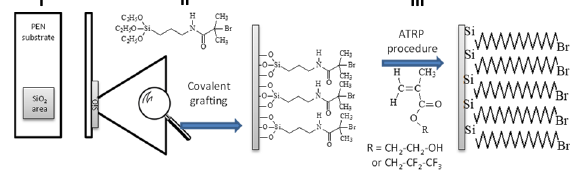
Fig. 2: General scheme summarizing the stepwise strategy used for surface modification of PEN substrate by (i) inkjet printing of silica pattern (0.5 * 0.5 mm 2 ), (ii) grafting the silane functionalised with the ATRP initiator and (iii) the growth of the polymer brushes using ATRP procedure.